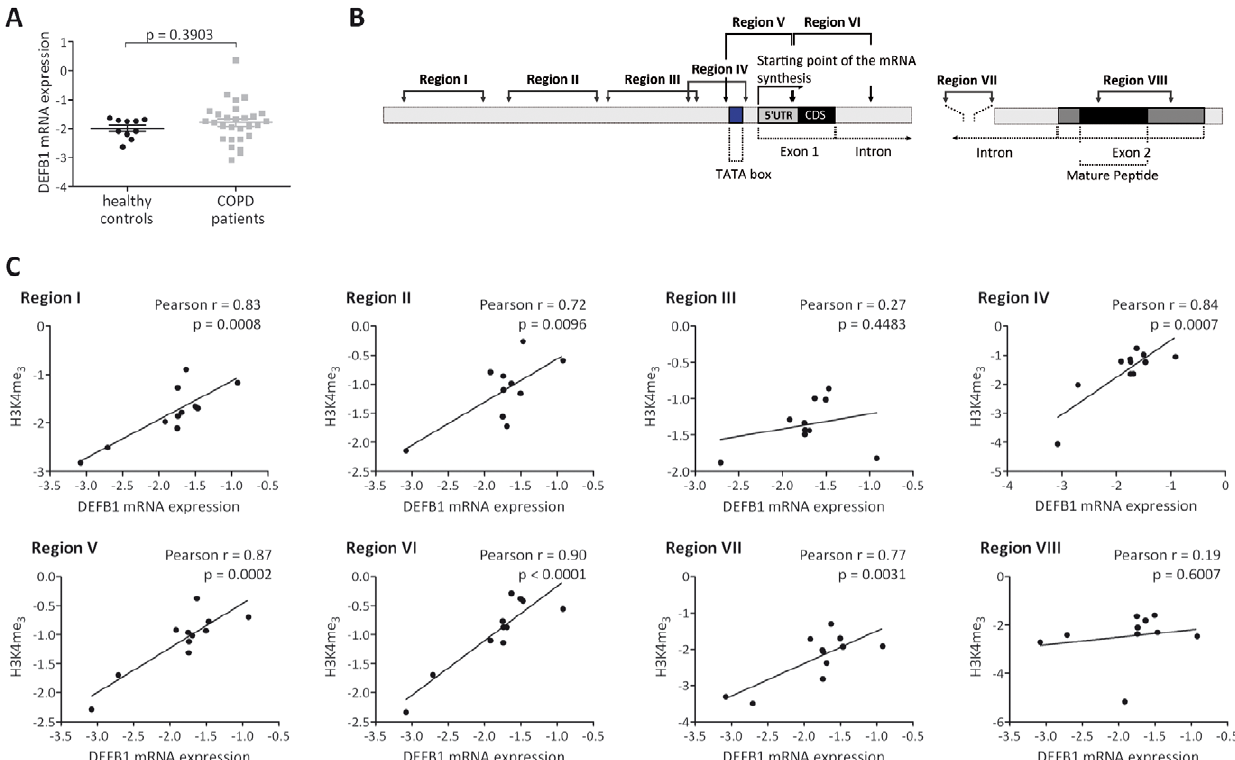
Figure 4. Analysis of histone H3 lysine 4 methylation (H3K4me 3 ) within the DEFB1 locus in BAL fluid cells. ( A ) Expression levels of DEFB1 mRNA in BAL fluid cells from patients with COPD (N=34) and healthy controls (N=10). Levels of DEFB1 mRNA were quantified by Real-time PCR, variations of transcript levels were corrected by b 2-M mRNA levels and log transformed for statistical analysis. Analysis of variance between patients with COPD and healthy controls was performed by the use of the unpaired t-test with differences p , 0.05 considered significant. Results are presented as mean 6 SEM, each symbol represents a single sample. ( B ) Schematic view of the DEFB1 gene (NCBI GeneID: 1672) with exons displayed as filled boxes; the transcriptional start site and location of PCR primer sets used in ChIP experiments are indicated; coding sequences are marked in black and 5 9 -UTR is shown in gray. ( C ) Correlations between levels of H3K4me 3 and DEFB1 mRNA in BAL fluid cells from study participants (N=11) regardless of their COPD status. Levels of H3K4me 3 were analyzed by ChIP using specific antibodies and quantified by Real-time PCR. The ChIP values are expressed as % of input corrected by subtracting values for no-antibody control and normalized on total histone H4. Correlations analysis was performed using Pearson correlations with differences p , 0.05 considered significant. Each symbol represents a single